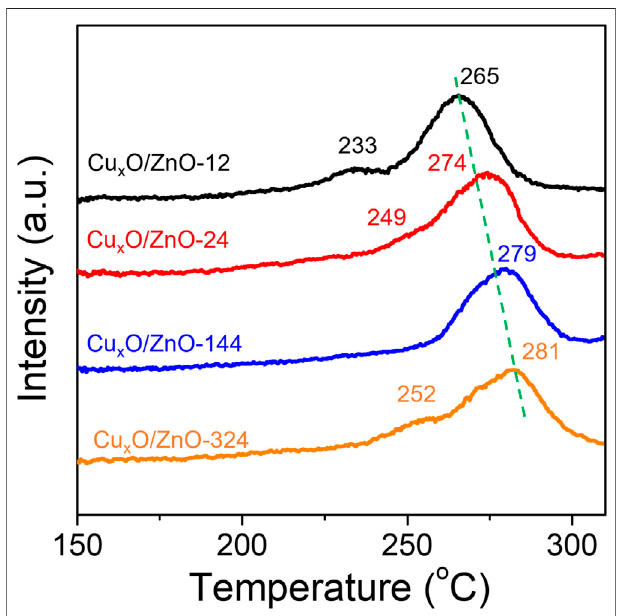
FIGURE 7 | H 2 temperature-programmed reduction pro Cu x O/ZnO